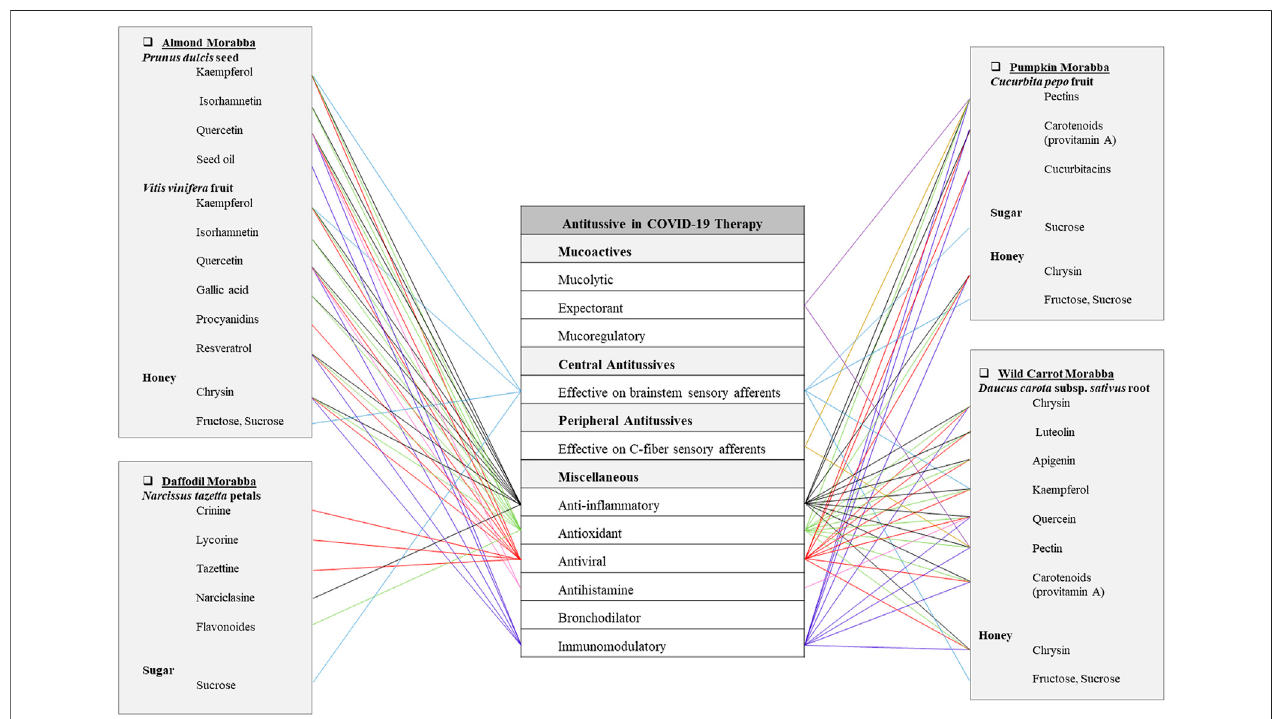
FIGURE 2 | Potentials of antitussive Persian Morabbas in COVID-19